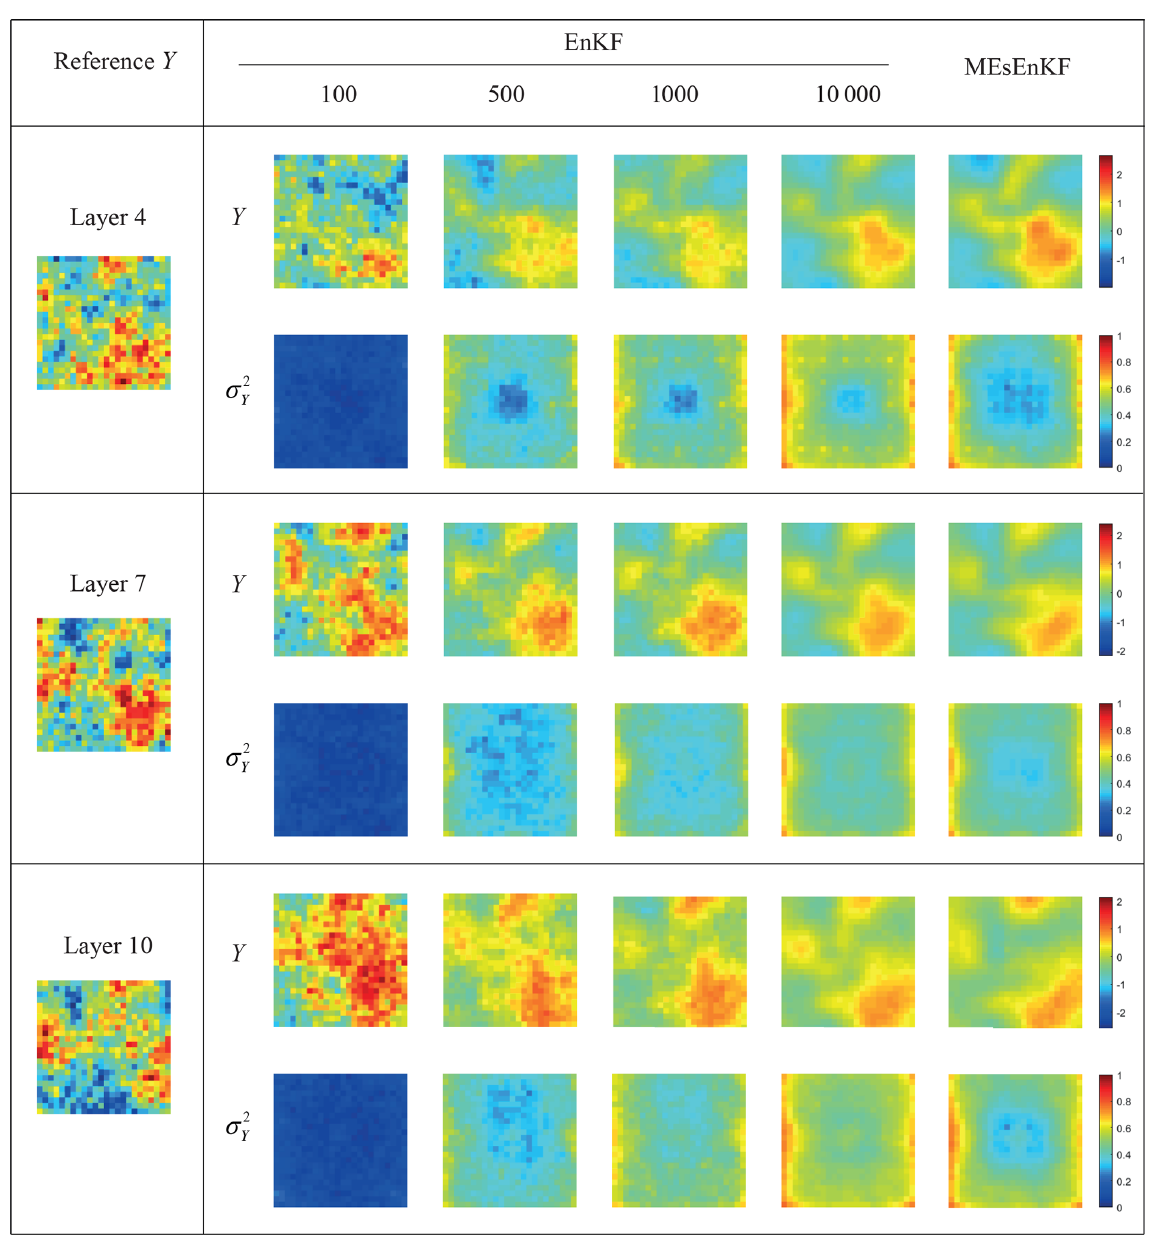
Figure 5. Reference Y field (left column) and estimates of the mean and variance of Y at the end of the assimilation process at layers 4, 7, and 10 for TC2#. Results computed via the MC-EnKF (with 100, 500, 1000, and 10000 realizations) and MEs-EnKF are